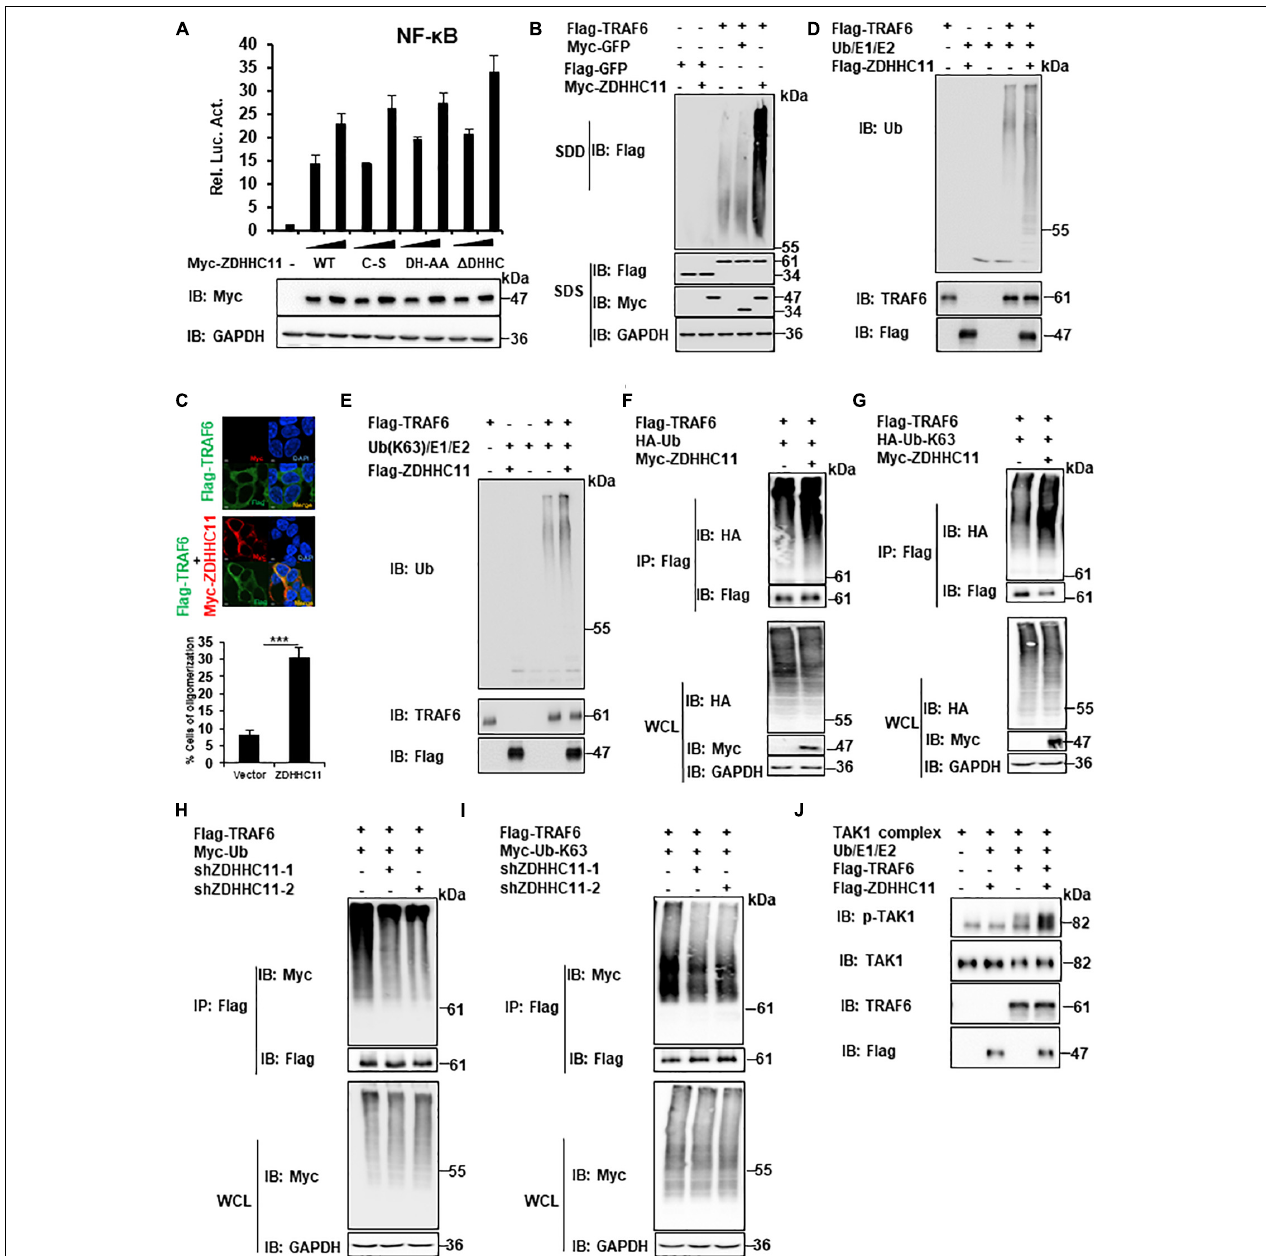
FIGURE 5 | ZDHHC11 increases TRAF6 E3 activity by enhancing TRAF6 oligomerization. (A) HEK293T cells were cotransfected with an empty vector or expression plasmids encoding wild-type ZDHHC11 (100 ng) or its mutants (100 ng) and a NF- κ B-Luc reporter plasmid (20 ng). After 24 h, reporter assays (upper panel) and immunoblot assay (lower panels) were performed. (B) HEK293T cells were cotransfected with the indicated expression plasmids. 24 h later, cell lysates were separated by SDD-AGE (upper panel) or SDS-PAGE (lower panels), followed by immunoblot analysis. (C) HEK293T cells were transfected with the indicated plasmids (500 ng/each) for 24 h, then stained with the indicated antibodies. The images were taken by confocal microscopy. Scale bars, 2 µ m. The percentage of cells with larger granules was counted in 150 cells. (D,E) Purified TRAF6 and ZDHHC11 were incubated as indicated in a reaction mixture containing ATP, E1, E2, and Ub (D) , or Ub-K63 (E) for 1 h at 30 ◦ C, then analyzed by immunoblotting. (F,G) HEK293T cells were transfected with TRAF6 (1 µ g) and ZDHHC11 (1 µ g) or empty vector together with HA-tagged wild-type Ub (HA-Ub; F) , HA-Ub-K63 (G) plasmids (1 µ g/each). At 24 h post-transfection, Co-IPs were performed with anti-Flag beads, followed by immunoblotting. (H,I) HEK293 C6 cells were infected with lentivirus expressing shRNA that targeted different coding regions of ZDHHC11 (shZDHHC11-1 and shZDHHC11-2) or an empty vector for 48 h. Then cells were cotransfected with TRAF6 (1 µ g) and Myc-tagged wild-type Ub (Myc-Ub; H) or Myc-Ub-K63 (I) plasmids (1 µ g). After 24 h of transfection, cell lysates were harvested for immunoprecipitation with anti-Flag beads, followed by immunoblotting. (J) Purified TRAF6, ZDHHC11, and TAK1 complex were incubated as indicated in a reaction mixture containing ATP, E1, E2, and Ub for 1 h at 30 ◦ C, then analyzed by immunoblotting. Data shown in (A) is representative of three independent experiments (mean ± SD of duplicate experiments). ***P < 0.001 significant versus the control groups. All blots are representative of three independent experiments.